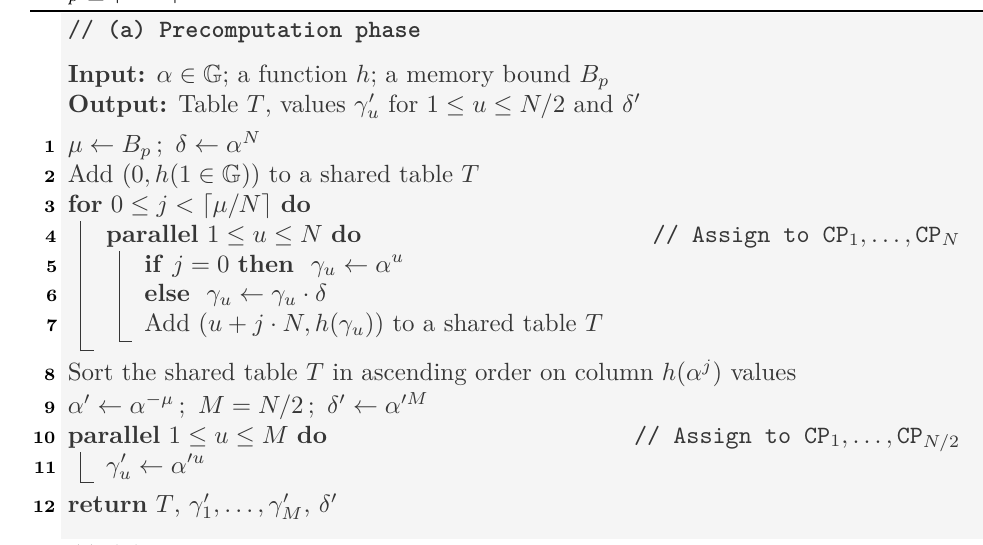
Algorithm 4: Parallel baby-step giant-step algorithm for discrete logarithms with precomputation using N parallel cores (where N is even). (a) The precomputation phase computes a table T with a memory bound B computation phase solves the discrete logarithm in the interval [ − B, B ] given that d√ B p ≥ B e